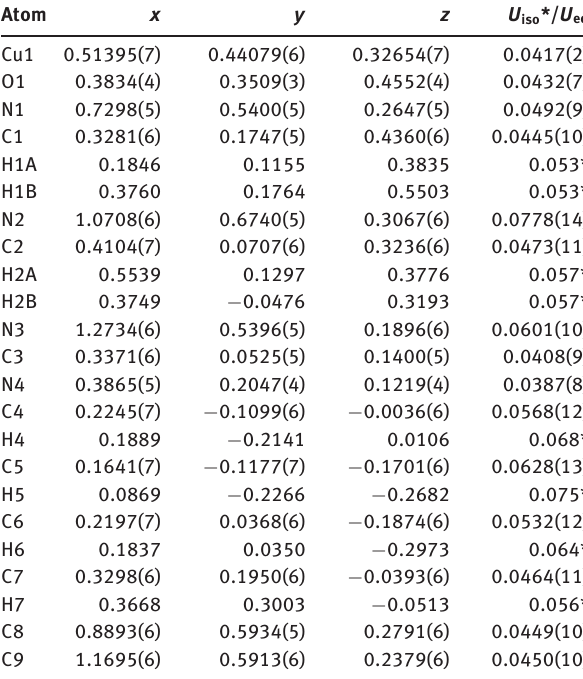
Table 2: Fractional atomic coordinates and isotropic or equivalent isotropic displacement parameters (Å 2 ).